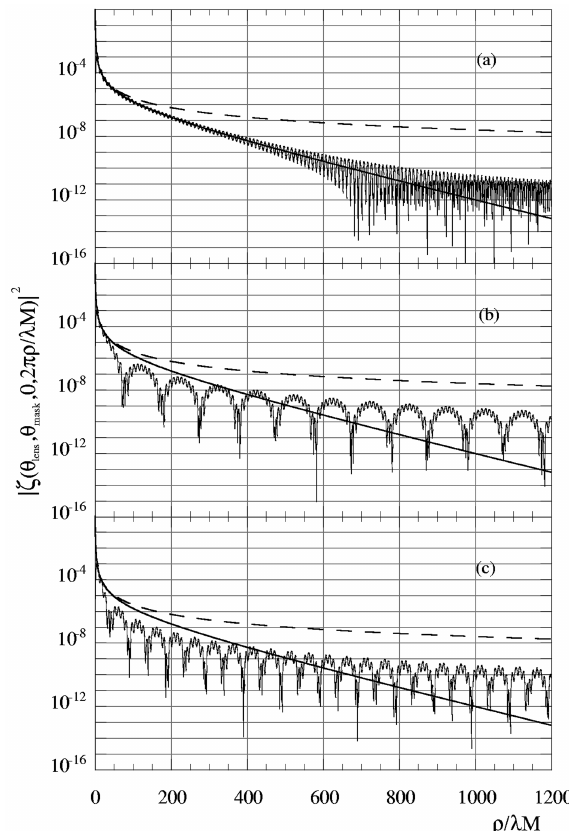
FIG. 5. Normalized image intensity distributions at the tail for